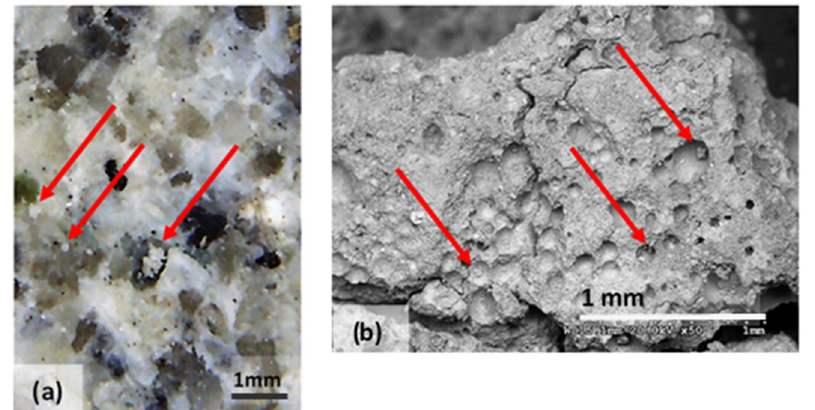
Figure 11. ( a ) Bioconsolidation of structural materials: in the optical microphotography of Bateig Blue ( b ) SEM microphotography, in backscattered electrons, of calcium mortar. It is possible to observe the formation of calcium crystals.